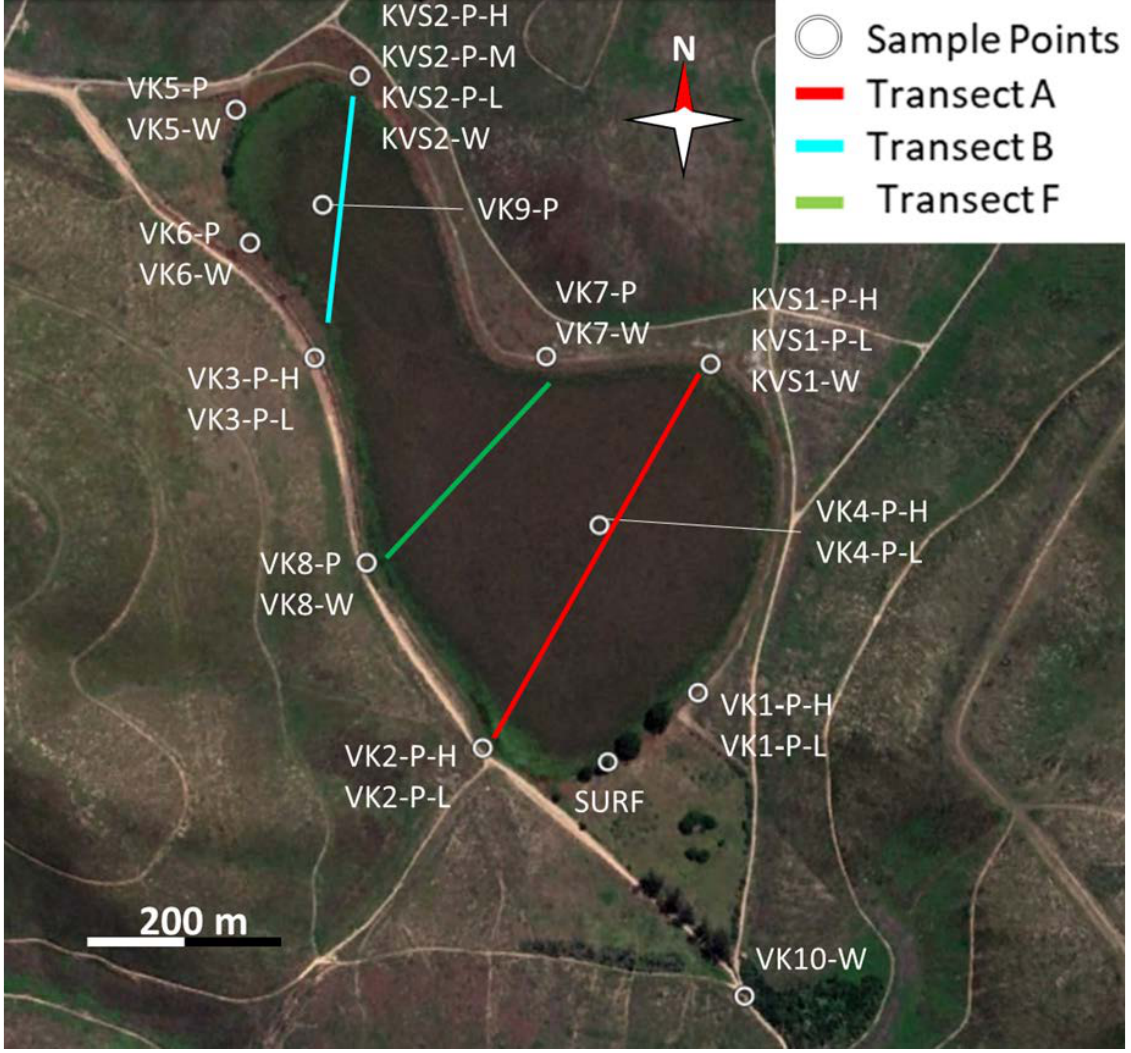
Figure 2. Aerial view of Vankervelsvlei (Google Earth, 18 Dec 2019), showing temperature and water level transects (A, B, F) plus locations of boreholes (e.g. VK1 - piezometer (P) or well (W) - relative height of piezometer in nest (H=high, M=medium, L=low)) and surface water sampling